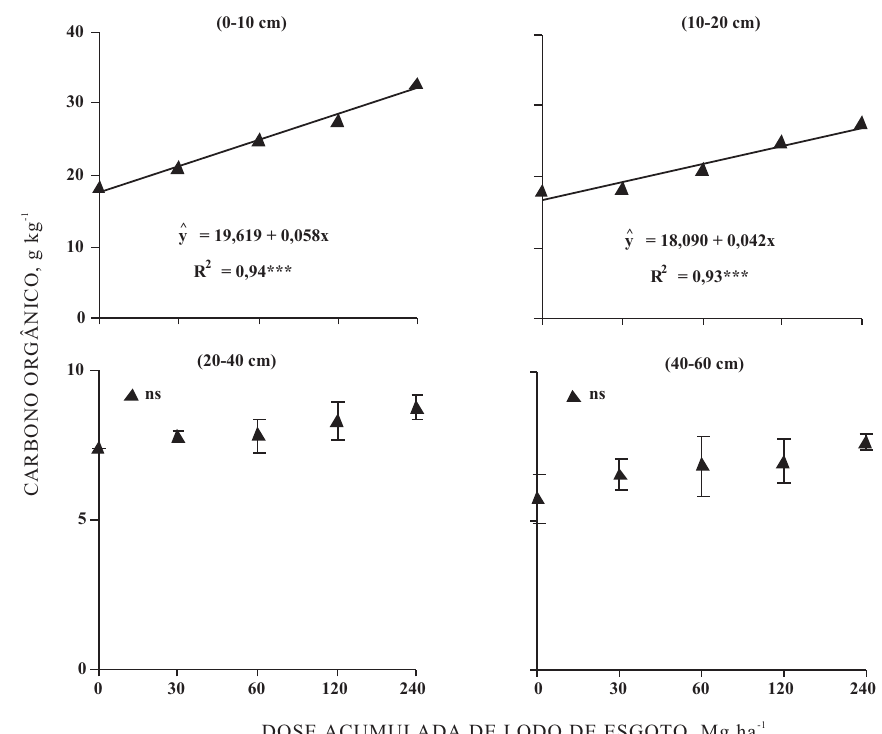
Figura 1. Teores de C orgânico em Latossolo sucessivamente tratado com lodo de esgoto, nas profundidades de 0–10, 10–20, 20–40 e 40–60 cm. (***: Significativo a 0,1 %). As barras verticais referem-se ao desvio- padrão da